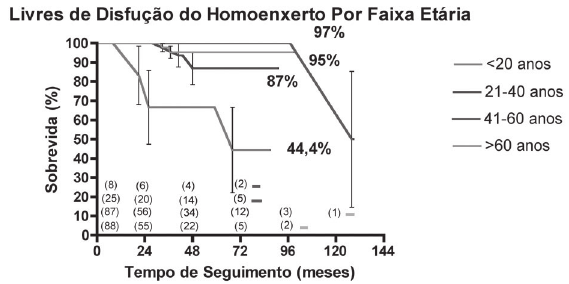
Fig. 6 - Probabilidade de reoperação e/ou “disfunção” do homoenxerto, em 282 pacientes submetidos ao implante de homoenxerto valvar aórtico, estratificadas por idade.